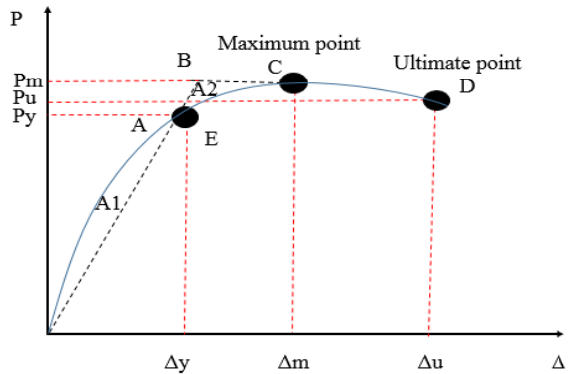
Figure 16. Equivalent energy elastic–plastic (EEEP) method.